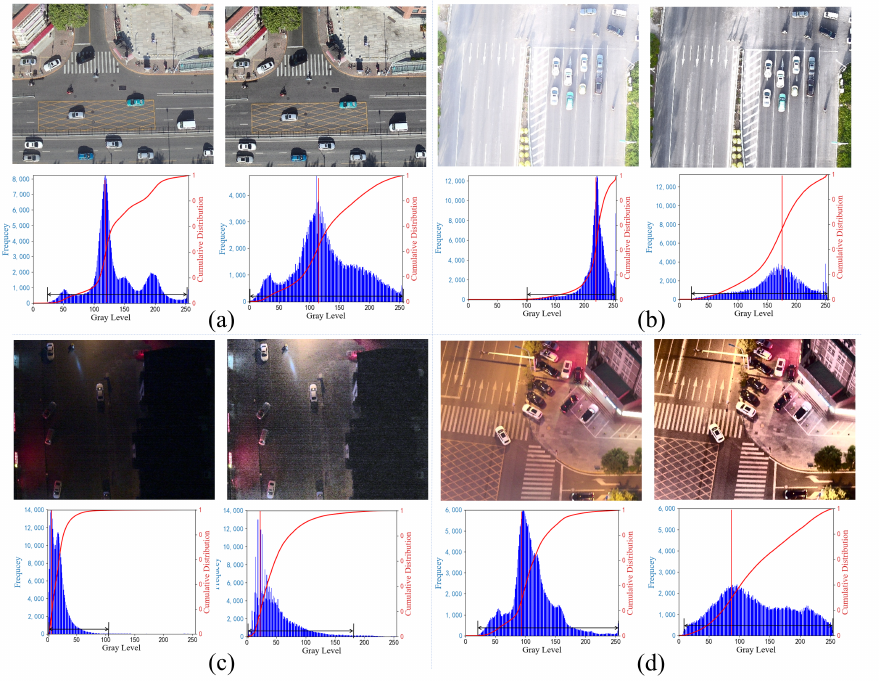
Figure 4. Original image (left) and result of contrast enhancement by CLAHE (right) for four categories of images with their histograms below: ( a ) bright, ( b ) foggy, ( c ) weak light at night, ( d ) strong light at